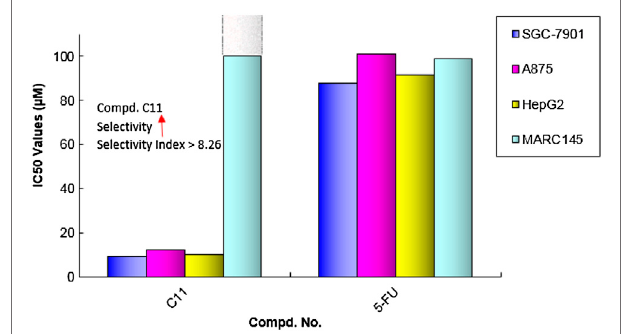
FIGURE 5 | IC 50 analysis for the highly potential compound C11 compared with